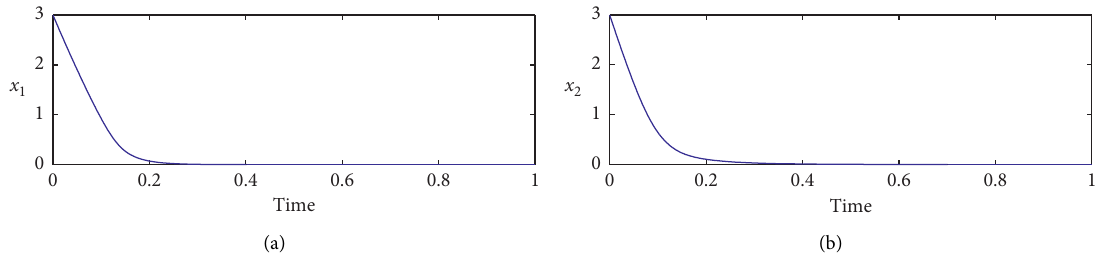
Figure 1: Transient behavior of (a) x